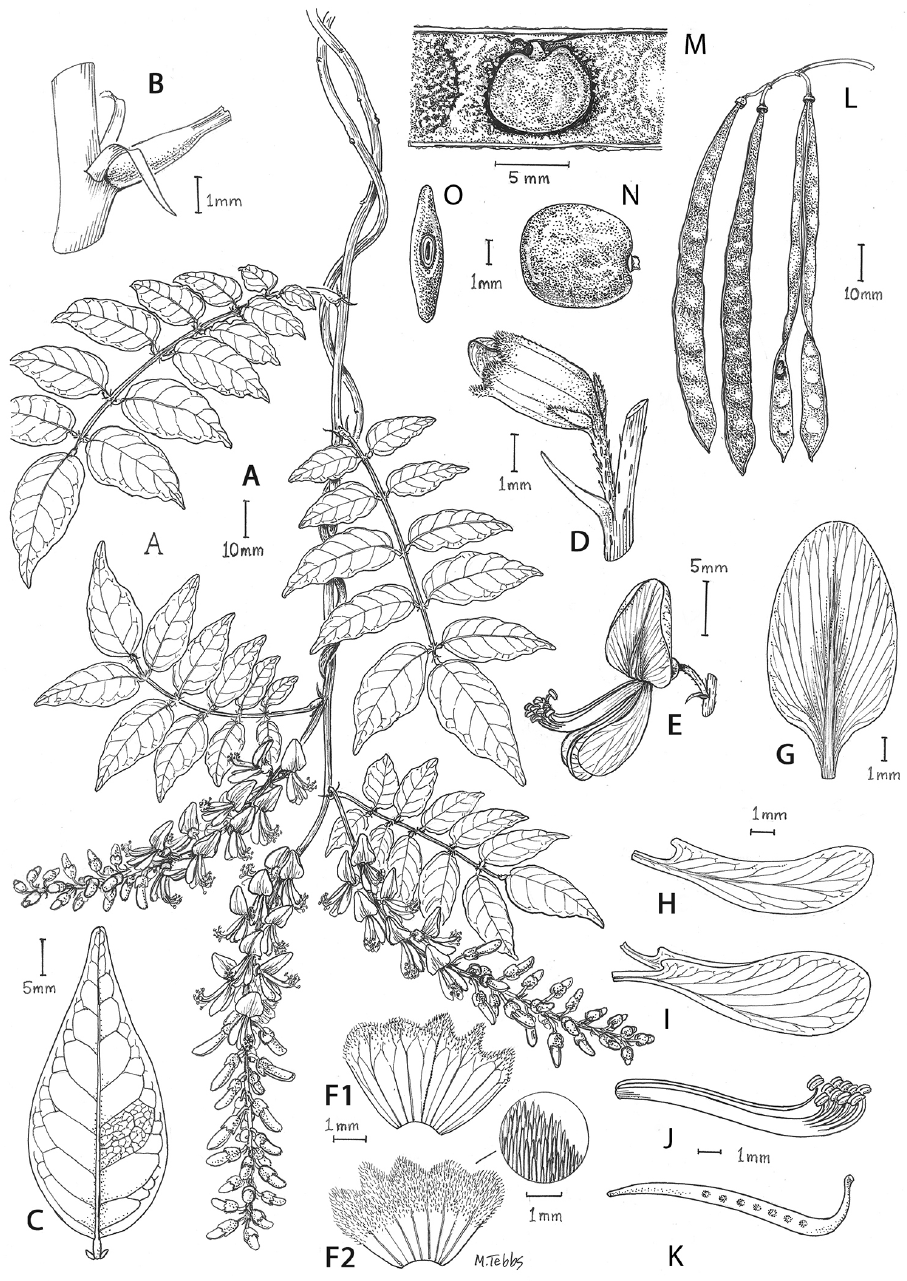
Figure 5. Wisteriopsis japonica (Siebold & Zucc.) J.Compton & Schrire. A Habit B stipels C lower sur- face of leaflet D flower bud with bract and bracteoles E flower F1 calyx outer surface F2 calyx inner sur- face and detail of hairs G standard petal inner surface H wing petal I keel petal J staminal column K ovary and style L pods M pod interior and seed N ventral view of seed O lateral view of seed A–C, E–K from Maximowicz s.n. 1863 D from Oldham 386, L–O from Togasi MSM1, 1950. Drawn by Margaret